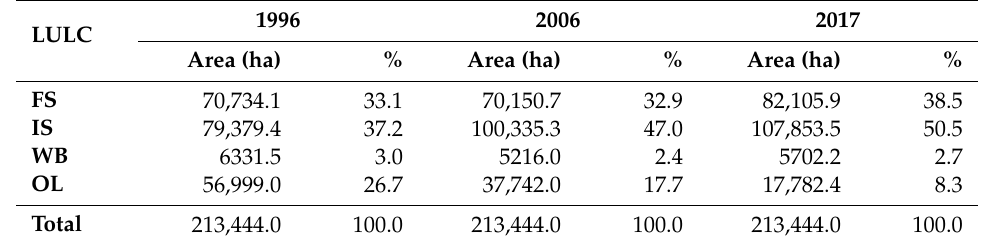
Figure 2. LULC and land-surface temperature (LST) of the study area. LULC in ( a ) 1996, ( b ) 2006, and ( c ) 2017; LST in ( d ) 1996; ( e ) 2006; and ( f ) 2017. Table 3. LULC composition in 1996, 2006, and 2017.